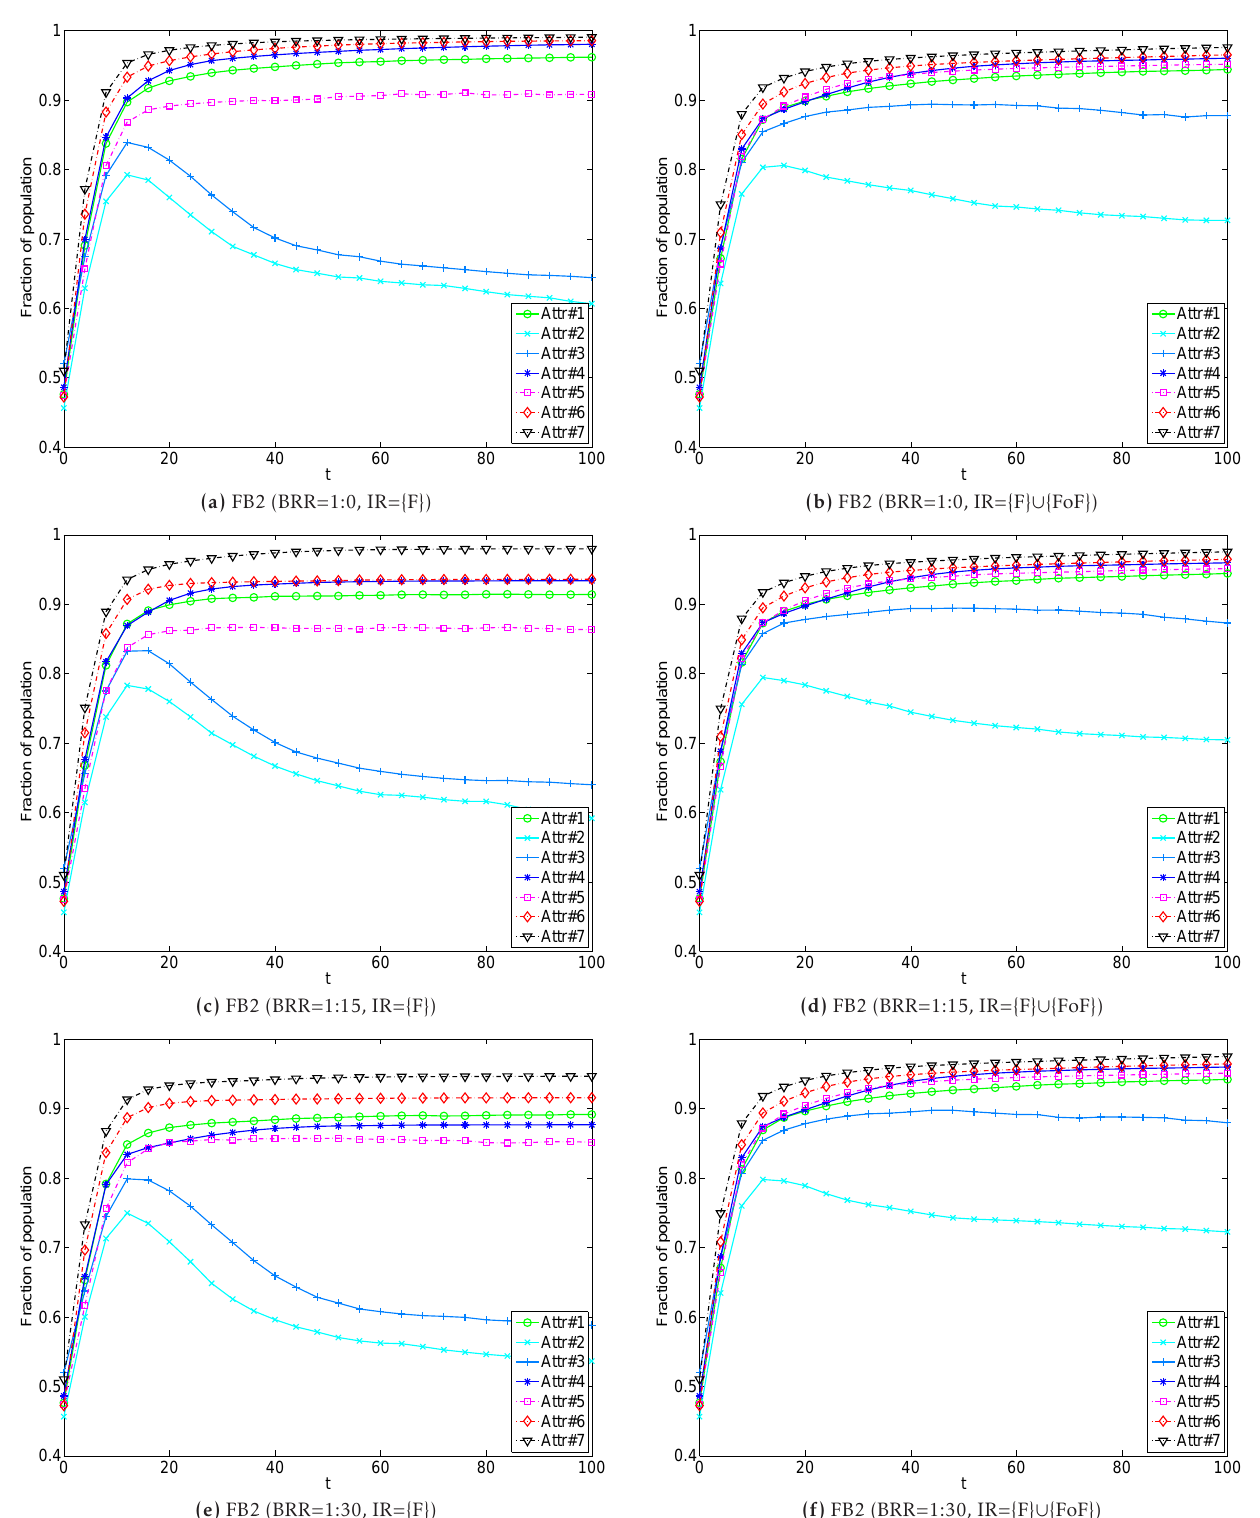
Figure 10. Attribute dynamics for the weighted evolutionary game in FB2. The figures in left column correspond to applying Friends as the influential range of the utility